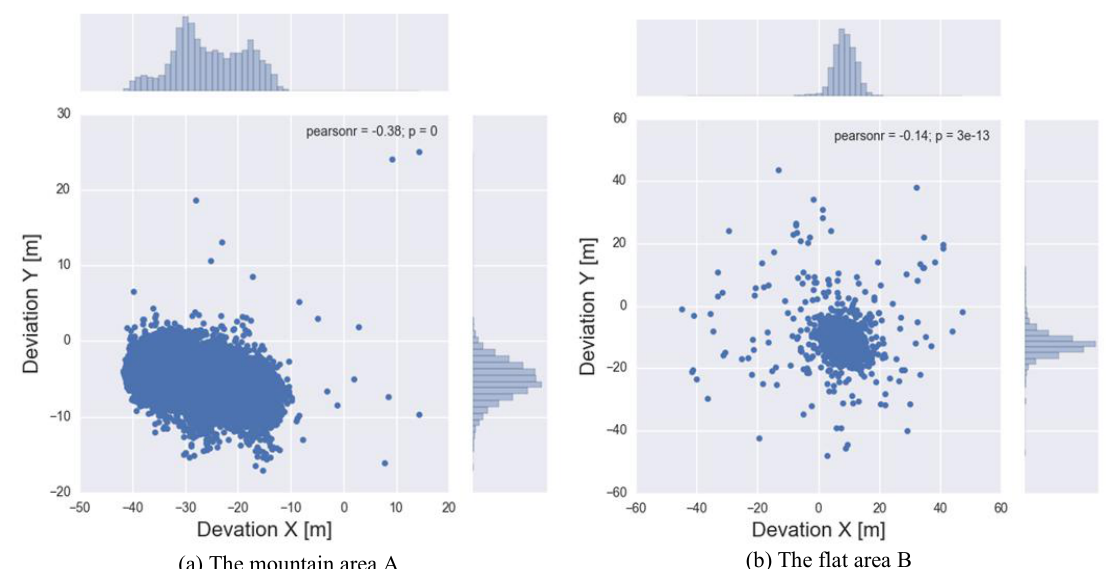
Figure 2. The deviations pattern of checking points